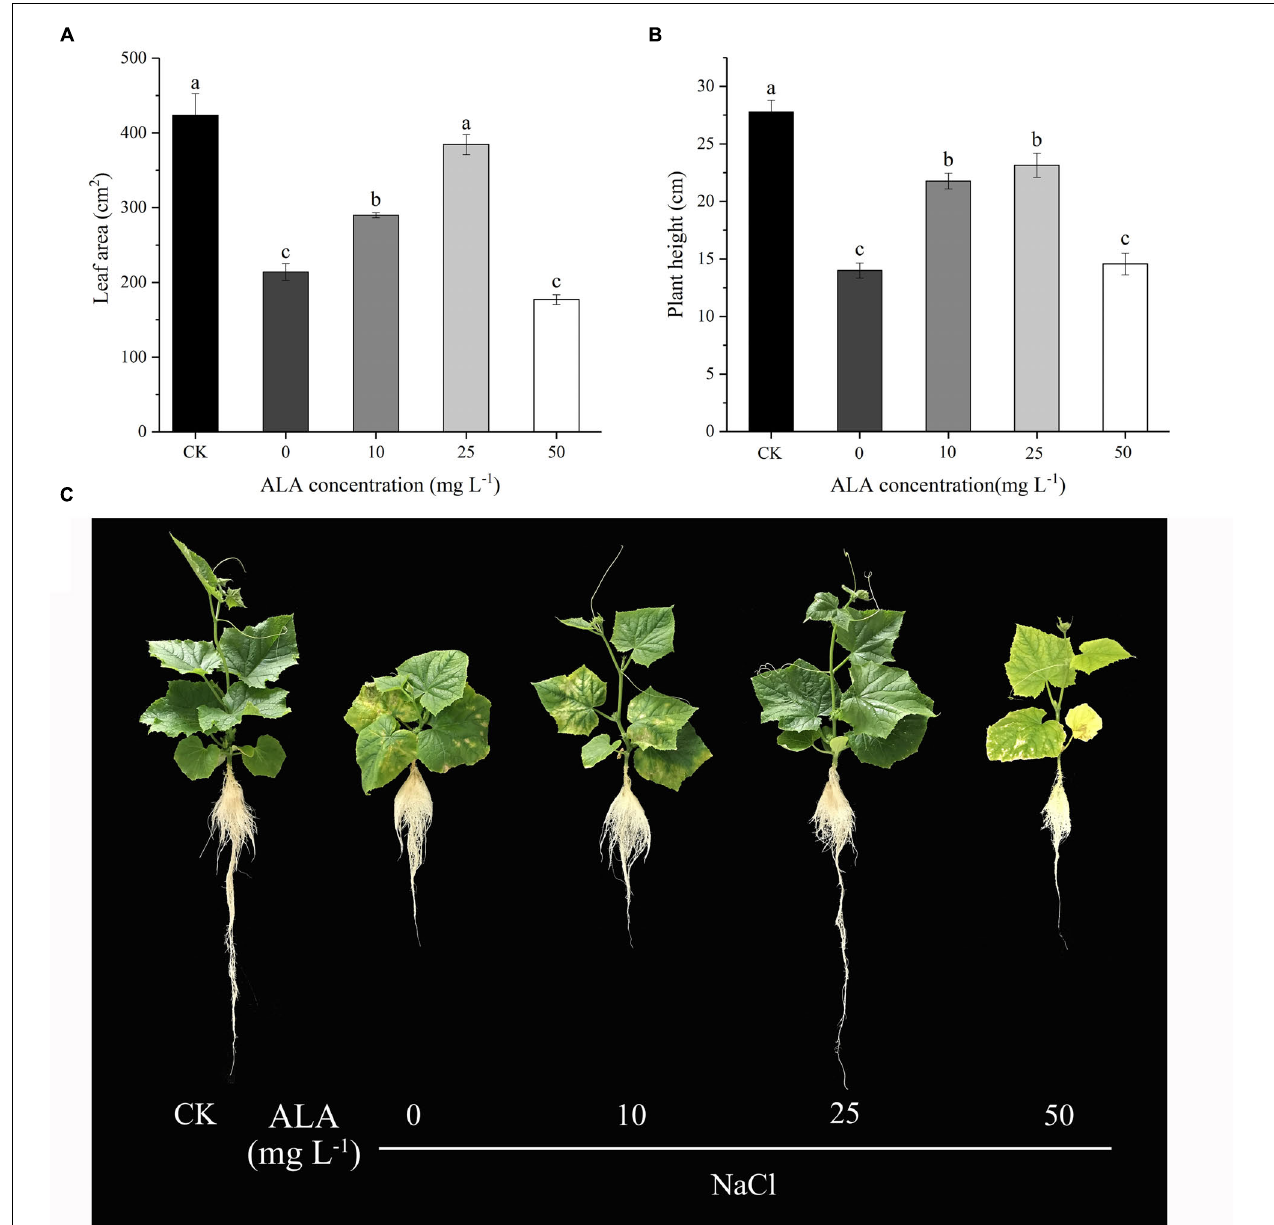
FIGURE 2 | Effects of different ALA concentrations on leaf morphology and plant height of cucumber seedlings under salt stress. (A) Leaf area changes of cucumber seedlings treated with different concentration of ALA. (B) Plant height of cucumber seedlings treated with different concentration of ALA. (C) Morphological changes of cucumber seedlings under various ALA concentrations. The data presented were the means of three plants ± SE of means ( n = 3, with 6 plants per replication). Treatment means with different letters indicate significant differences according to Tukey’s test ( p <